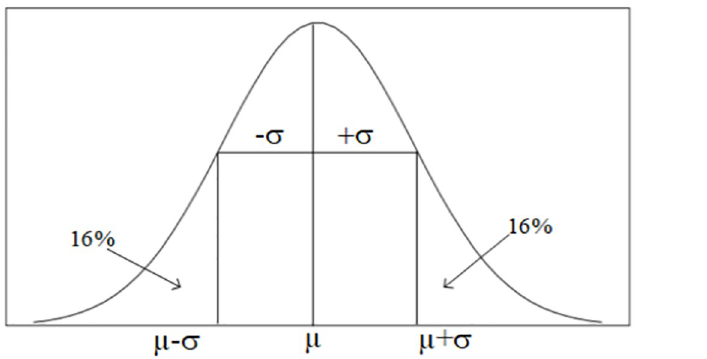
Fig 8. The normal distribution plot with a mean ( μ ) and standard deviation ( σ ). Where μ , and σ , represent the mean and standard deviation of the pixel distribution in a pea- nut plot and α is a constant which represents the effect of standard deviation on MI. In statistics, if a density plot is normally or near normally distributed, MI points to the left- wing of the curve where its accumulated density to the mean is about 16% when α = 1 (Fig 8). Under the assumption of α = 1, MI can also further enlarge the statistical difference between the two means for the diseased and healthy plots through the ratio between the healthy and diseased plots, the opposite way to the CV-based method through the ratio between the dis- eased and healthy plots. As a qualitative example, assuming μ = 0.3 and σ = 0.2 for the diseased plot and μ = 0.6 and σ = 0.1 for the healthy plot, the ratio between the mean for the healthy plot and the mean for the diseased plot is 0.6/0.3 = 2. Meanwhile, the MI for the healthy and diseased plots should be 0.5 and 0.1 respectively. The ratio between the MI for the healthy plot and the diseased plot is 0.5/0.1 = 5. This indicates that by using MI the relative difference between the healthy and diseased plots is 2.5 times higher than that using the means. This also indicates that the CV and MI methods are not overlapping with each other; rather, they are complementary to each other from opposite mechanisms. If one misses the target of detection, the other may be able to pick it up. Similar to the CV-based method, the quantitative influence of this relative ratio needs to be further studied in the future. The constant factor ( α ) may be variable to different indices. We explore whether an opti- mum value for the constant factor exists for each of the six VIs selected in this study. Hence, a sensitivity analysis for α from -2 to 2 (since the ± 3 σ represents only about 0.13% density on normal distribution, its effect is negligible on MI) was conducted and the coefficient of deter- mination was measured using regression analysis between the MI values and the manual dis- ease scores. We utilized the drone image taken at DAP-96 because the vegetation indices were highly correlated with the image at this growth stage. The experimental results are plotted in Fig 9. From Fig 9, we see that the optimal ( α ) value for LAI, SAVI, and DVI, is about zero, which indicates that the MI-based method for LAI, SAVI and DVI would be almost the same to the mean-based method. The optimal ( α ) value for NDRE and SR is around 0.8 to 1.2, which indi- cates that the MI-based method would be better in distinguishing the disease status by NDRE and SR with a value smaller than the mean value by about one standard deviation. The optimal ( α ) value for REVI is negative around –1.5, which indicates that the MI-based method would be better in distinguishing the disease status by REVI with a value greater than the mean value by about 1.5 σ . Note that REVI is positively correlated with the manual LLS score (Table 2), in contrast to the other five selected VIs.